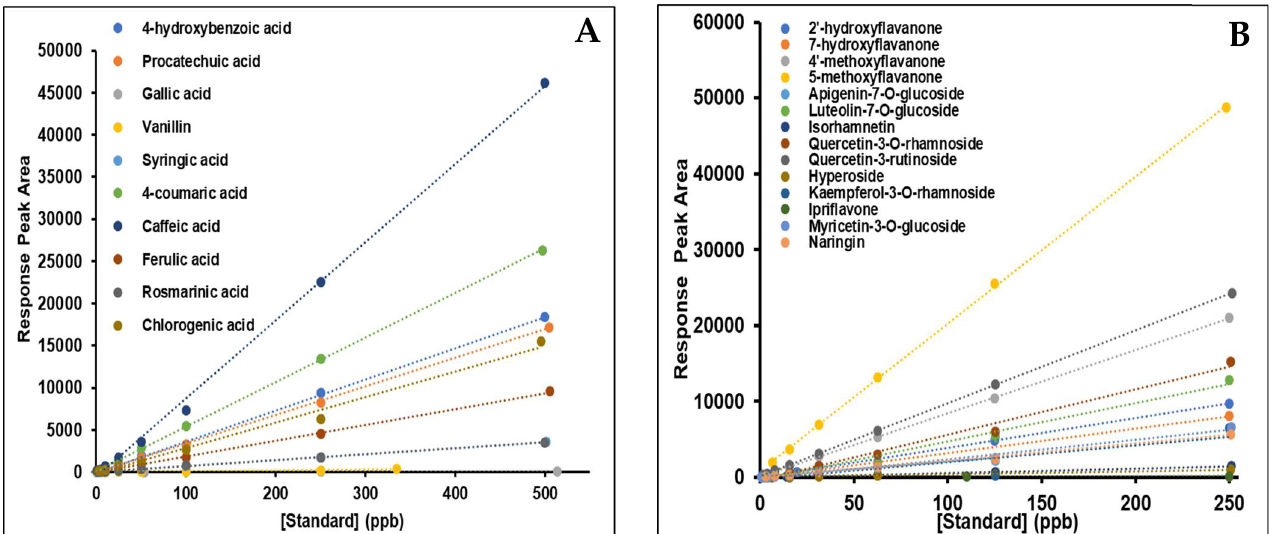
Figure 1. Calibration curves of the corresponding MRM fragments of ( A ) phenols; 4-hydroxybenzoic acid, protocatechuic acid, gallic acid, vanillin, syringic acid, 4-coumaric acid, caffeic acid, ferulic acid, rosmarinic acid and chlorogenic acid and ( B ) flavonoids; 2’-hydroxeflavanone,